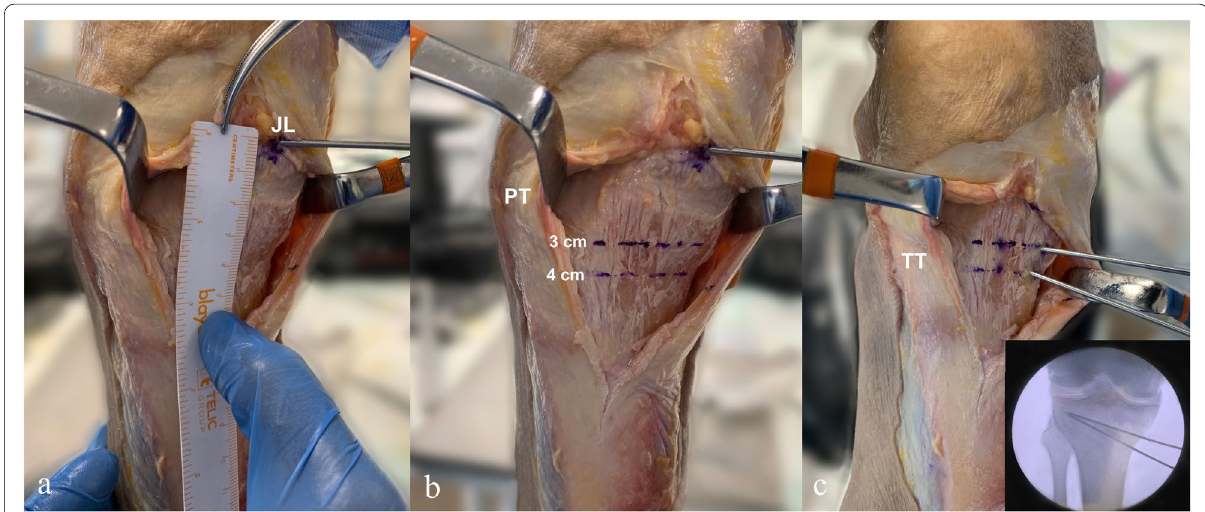
Fig. 2 Medial starting point. Anteromedial view of the right knee. ( a ) Kirschner wire located at the level of the joint line and measurement of the site where the osteotomy will begin. JL, joint line. ( b ) The methodology is graphed according the sites where the osteotomy will begin according to randomization. PT, patellar tendon ( c ) Two 2.4‑mm wires are introduced at 3 and 4 cm, which will serve as a guide for performing the osteotomy for the 3 and 4 cm groups, respectively. A wide dissection of skin and subcutaneous tissue is performed to facilitate understanding of the image. TT, tibial tuberosity